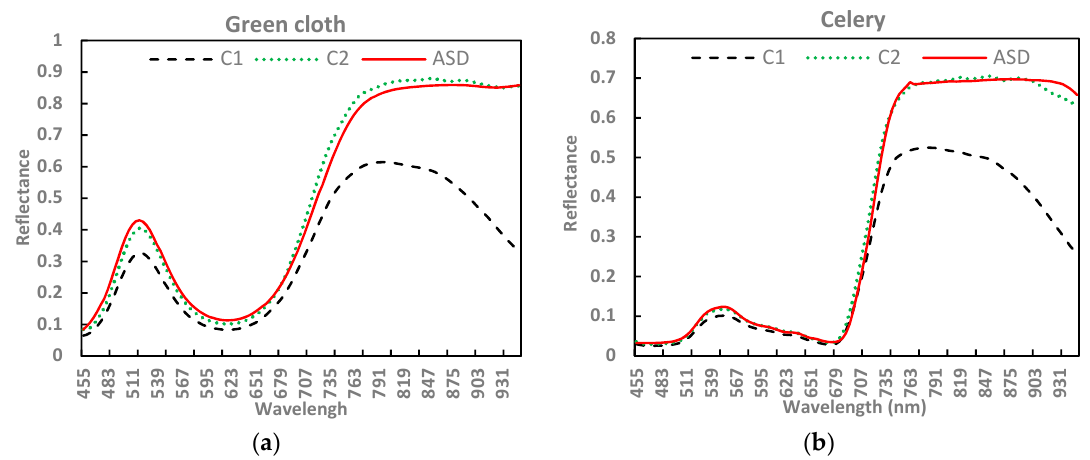
Figure 13. Reflectance of a green tarp ( a ) and celery ( b ), representative of green vegetation; C1 stands for reflectance curves calibrated according to Equation (12); C2 represents reflectance curves calibrated according to Equation (13).